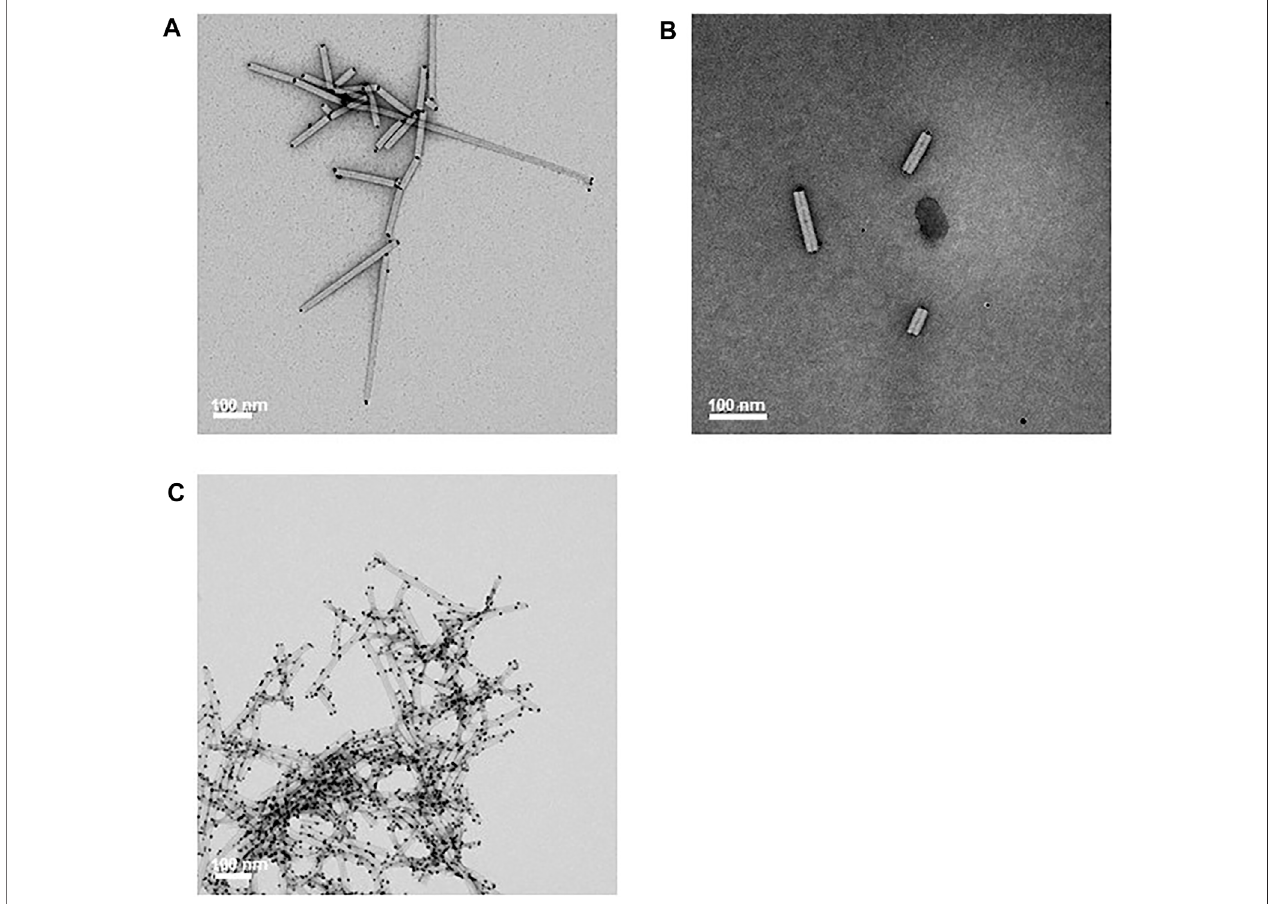
FIGURE 5 | Stained transmission electron microscopy images. (A) and (B) shows selective gold binding to the ends of CP/OAS-A8 nanorods. (C) The effect of an excess (20-fold) of colloidal gold on the binding to the nanorod outer surface in 5 mM citric acid. Scale bars 100 nm as shown.